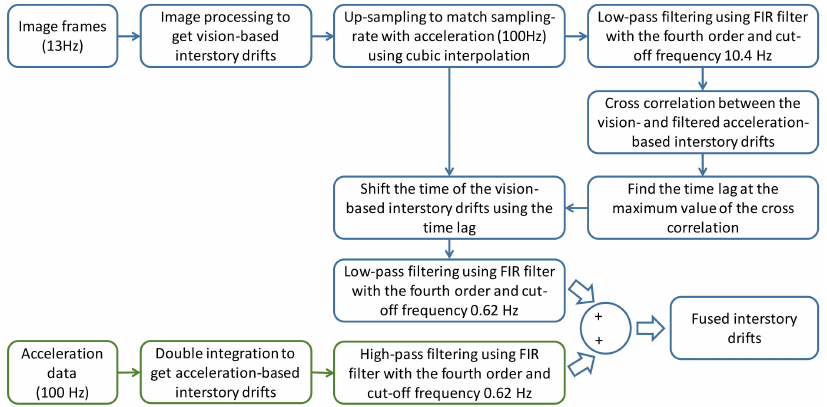
Figure 6. The root mean square error (RMSE) values of the fused interstory drifts using di ff erent cut frequencies.